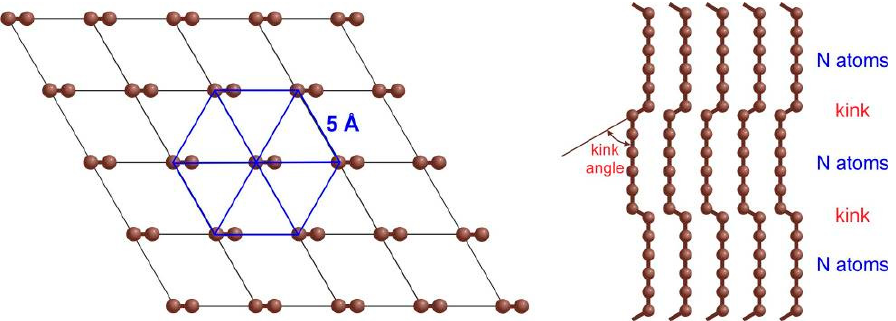
Figure 3. Scheme of the atomic arrangement in LCC crystal, given in two normal projections.